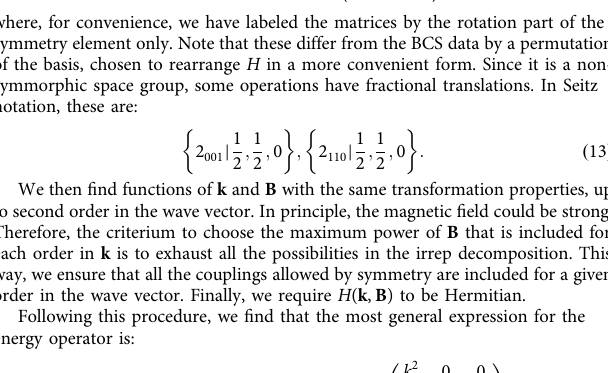
Table 2 Decomposition of the product of representations D * × D . Each row labels the decomposition of the term-wise product, considering that D = D 1 + D 5 is derived from a space group irrep induced from the sum of small irreps T 1 + T 5 , which is then restricted to the arms K 1,2 . The terms in the reduction are small irreps of the little groups at Γ and X 3 = (0, 0, 1/2). The labels for the X irreps are those from